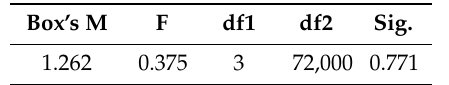
Table 6. Box’s test of equality of covariance matrices.